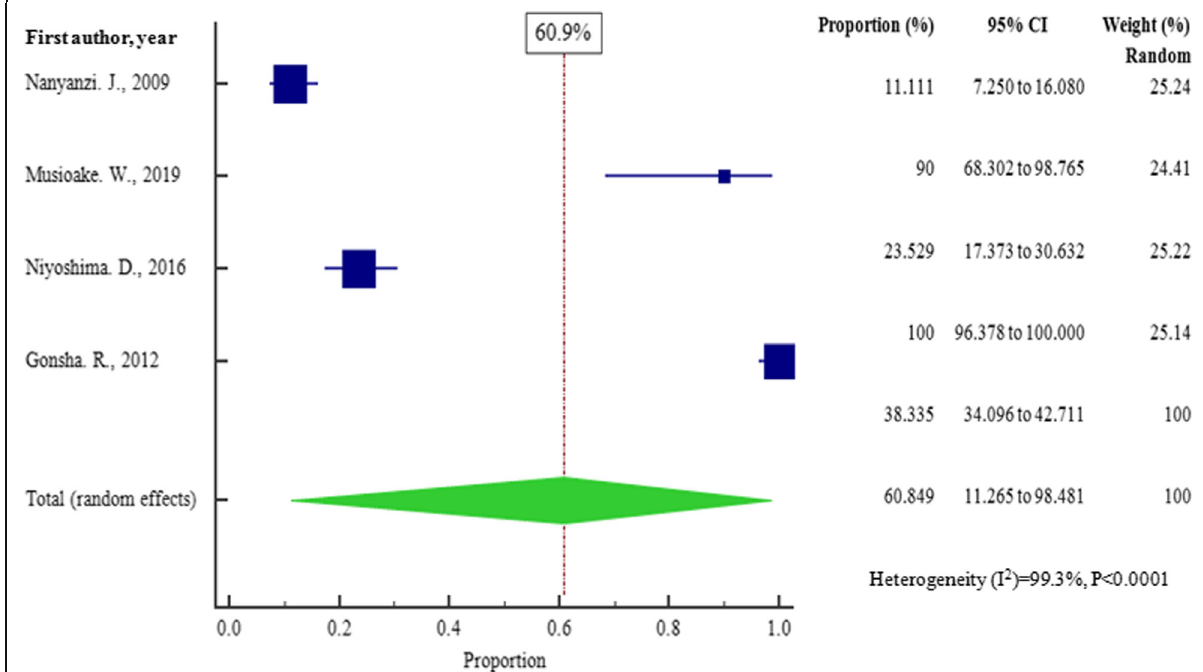
Fig. 10 Pooled prevalence estimates of bacterial contamination in herbal medicines sold in Uganda from the year 2000 to 2020, using